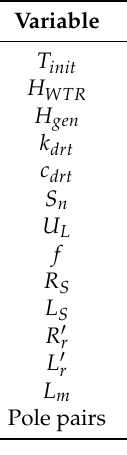
Table A1. Parameters of Type 1 WT